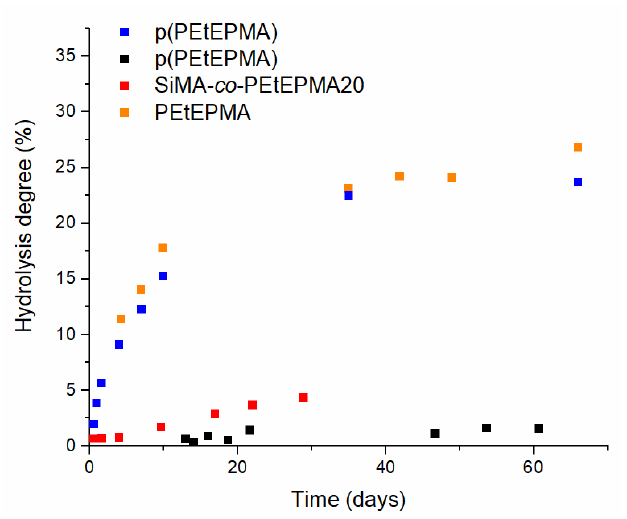
Figure 4. Hydrolysis kinetics of polyphosphonate-based samples in buffer solution (pH ~ 10) for p(PEtEPMA) (blue) and PEtEPMA (orange), in artificial sea water solution (pH ~ 8.2) for p(PEtEPMA) (black) and in THF-d8 with aliquot of buffer solution (pH ~ 10) for SiMA- co -PEtEP20 (red).